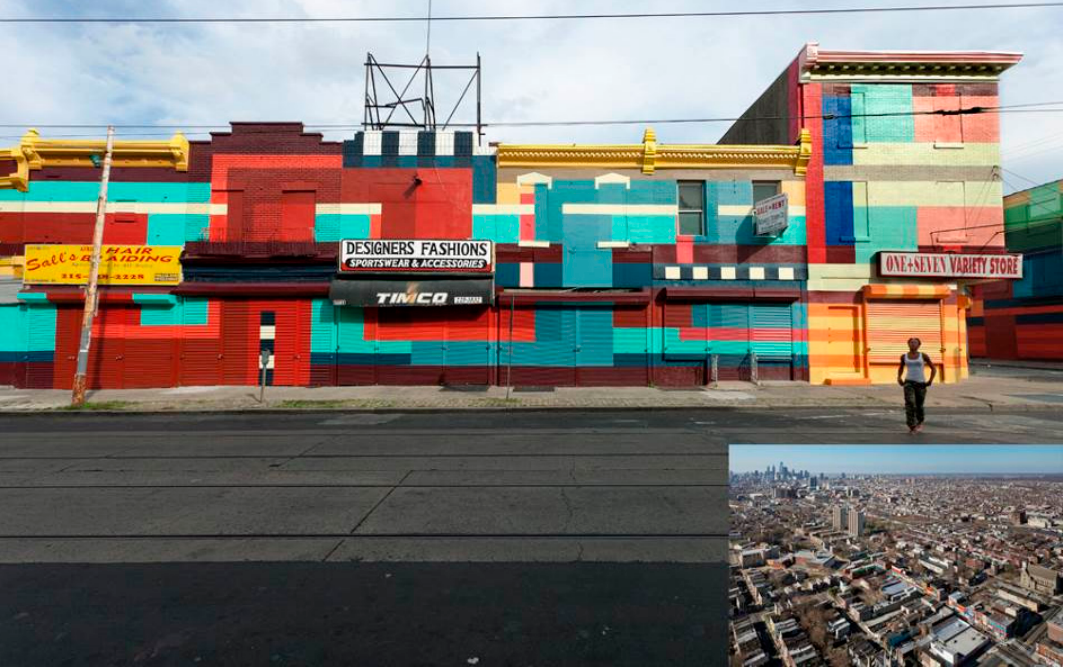
Figure 5. Picture of the mural created by Jeroen Koolhaas and Dre Urhahn for the project called Philly